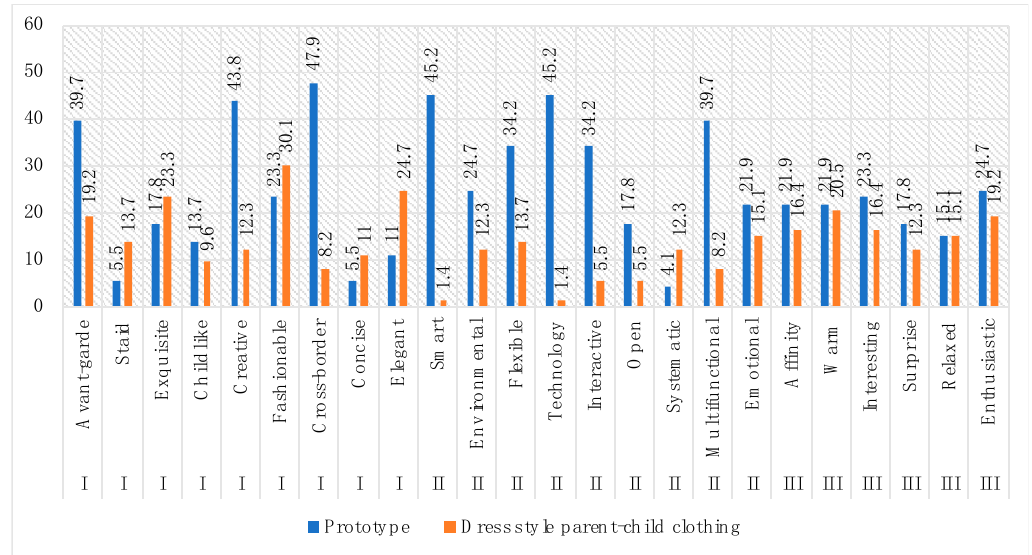
Figure 9. Frequency values of prototype and the Dress style parent–child clothing.